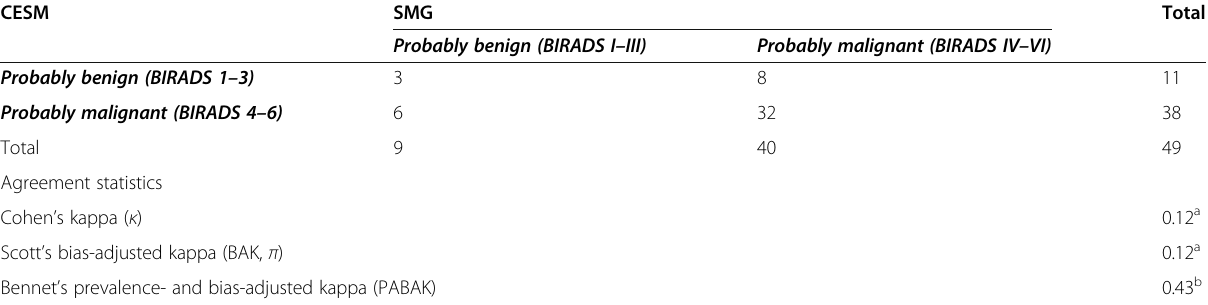
Table 14 Agreement between SMG and CESM regarding lesion classification as probably malignant or probably benign in patients with ACR